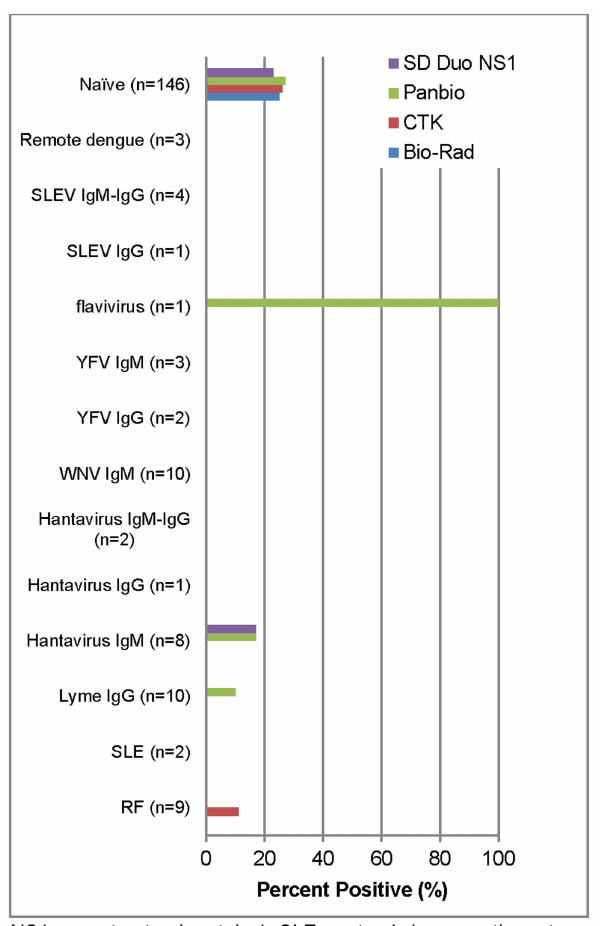
Figure 2. False positive rate DENV NS1 rapid diagnostic tests in DENV negatives and challenge panel specimens.